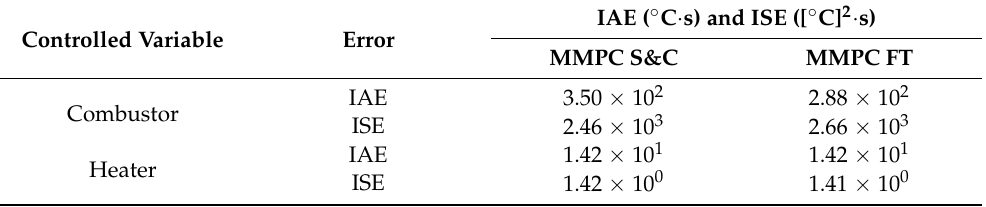
Table 20. Comparison of controller performance on the steam reformer unit (Disturbance Test).